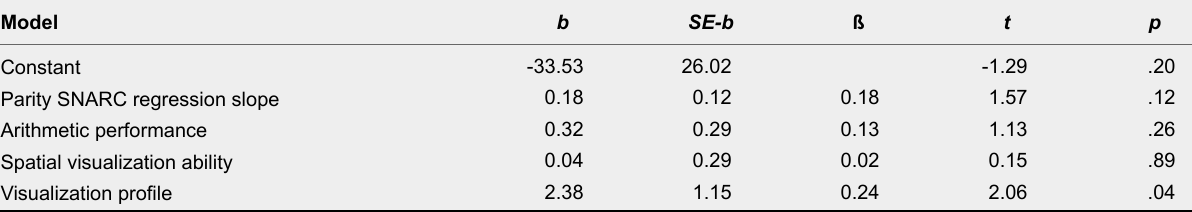
Multiple Linear Regression Analysis on the Magnitude SNARC Regression